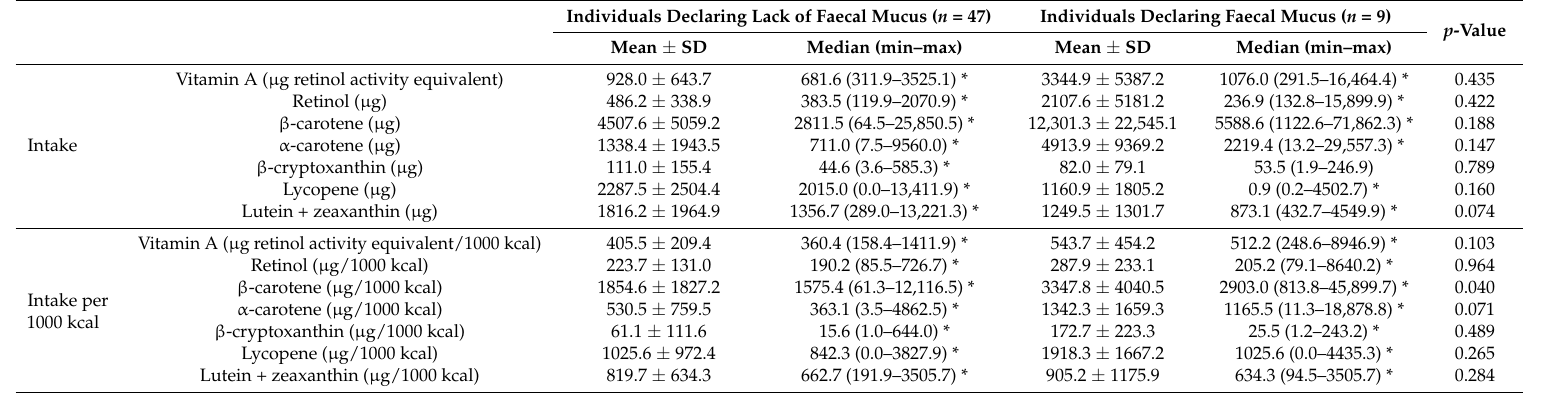
Table 3. The levels of retinoid intake in groups of individuals with ulcerative colitis declaring either a lack or presence of faecal mucus (comparison conducted using U Mann-Whitney test).